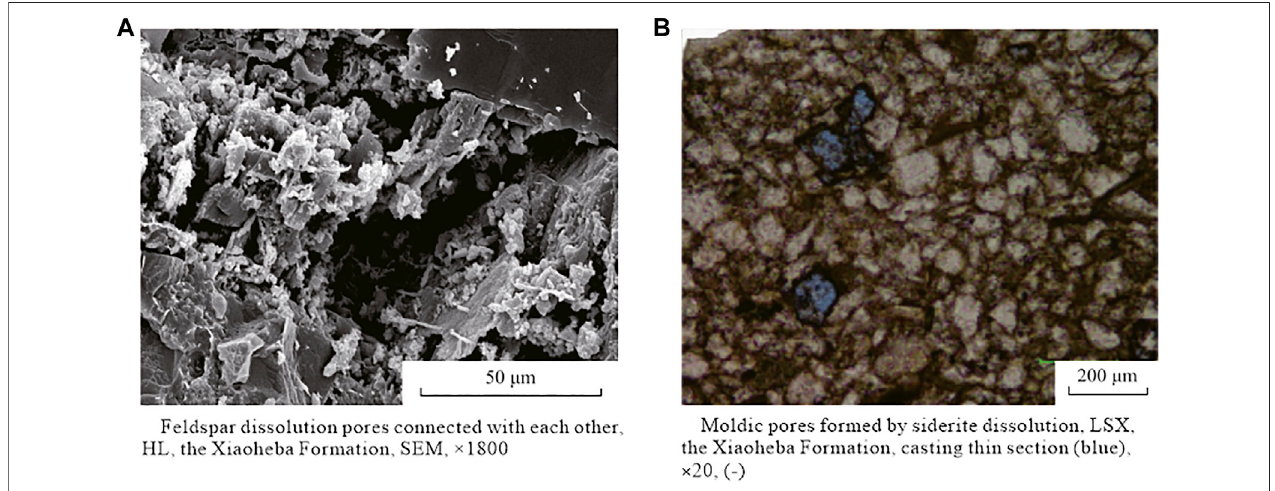
FIGURE9| TypesandfeaturesofdissolutionintheXiaohebaFormationreservoirsinSoutheastSichuan; (A) Feldspardissolutionporesconnectedwitheachother, HL, the Xiaoheba Formation, SEM, ×1800; (B) Moldic pores formed by siderite dissolution, LSX, the Xiaoheba Formation, casting thin section (blue), ×20, ( − ).